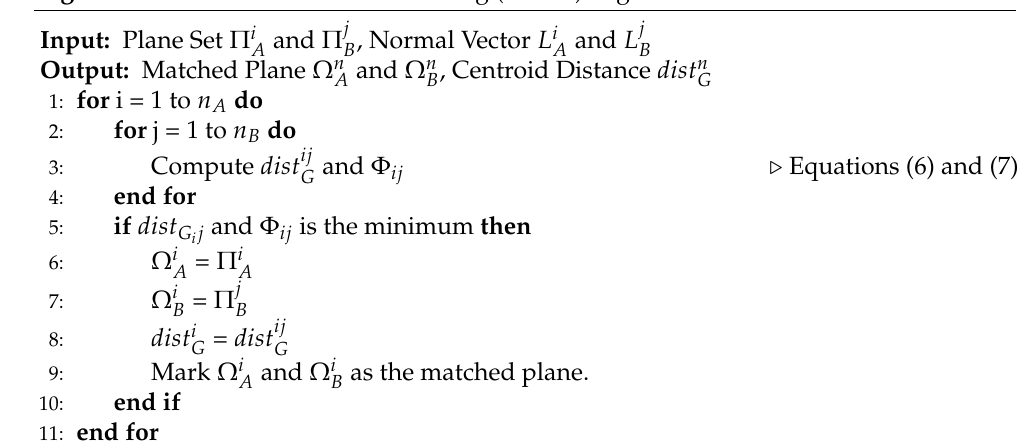
Algorithm 2 Point Cloud Plane Matching (PCPM) Algorithm